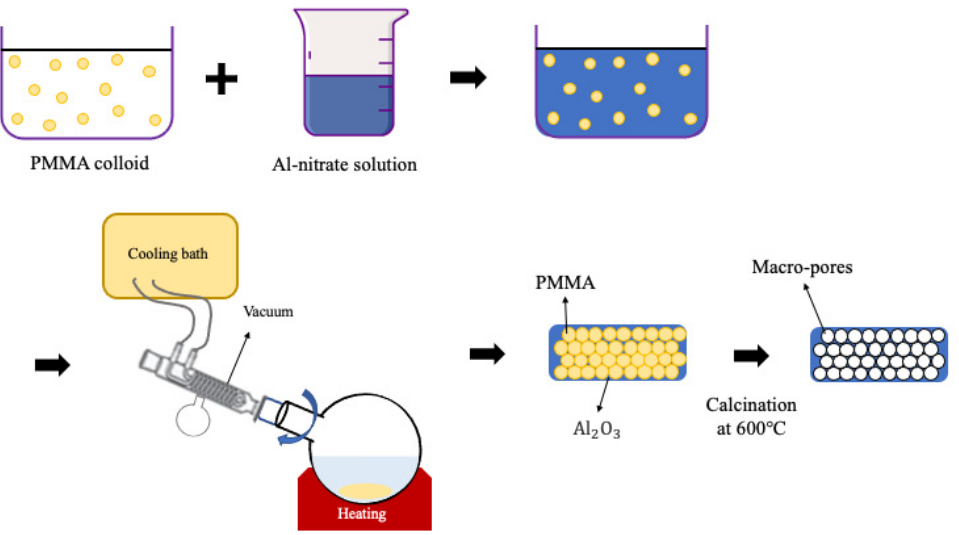
Figure 2. Procedure for the preparation of macroporous alumina by template method.